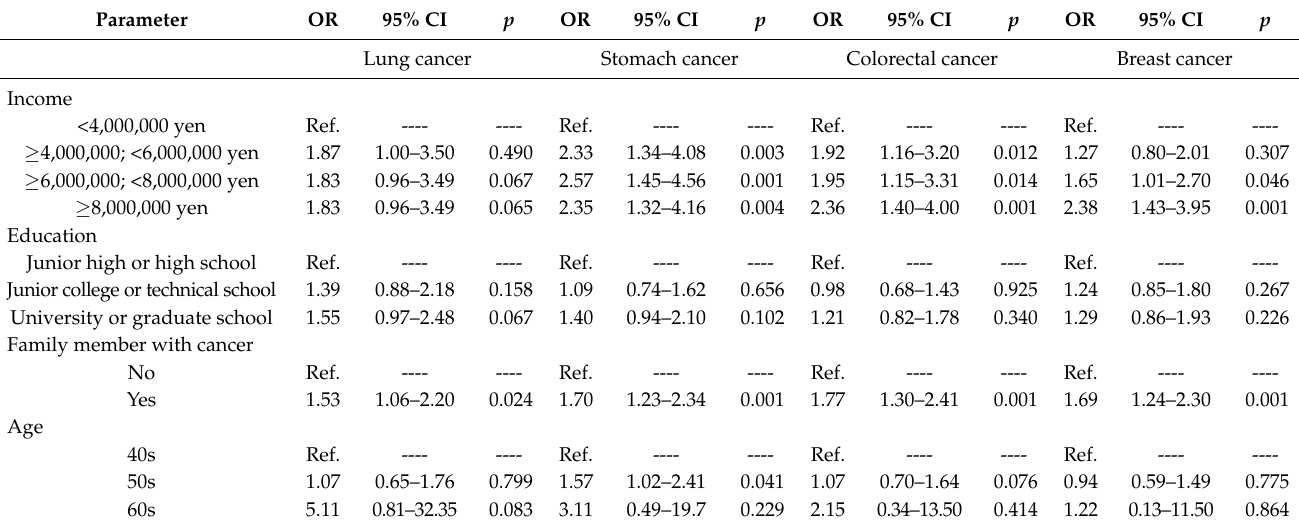
Table 5. Factors associated with site-specific cancer screening experience in women.